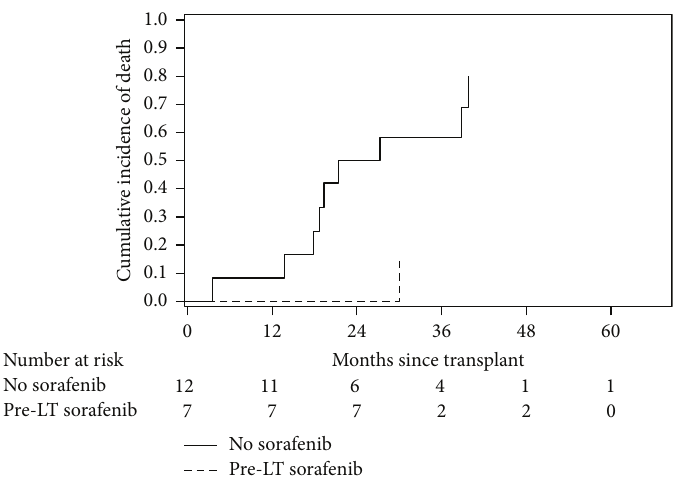
Figure 1: Mortality transplant patients with high-risk hepatocellular carcinoma at the Goergetown Transplant Institute, Washington, DC, by use of adjuvant pre-LT